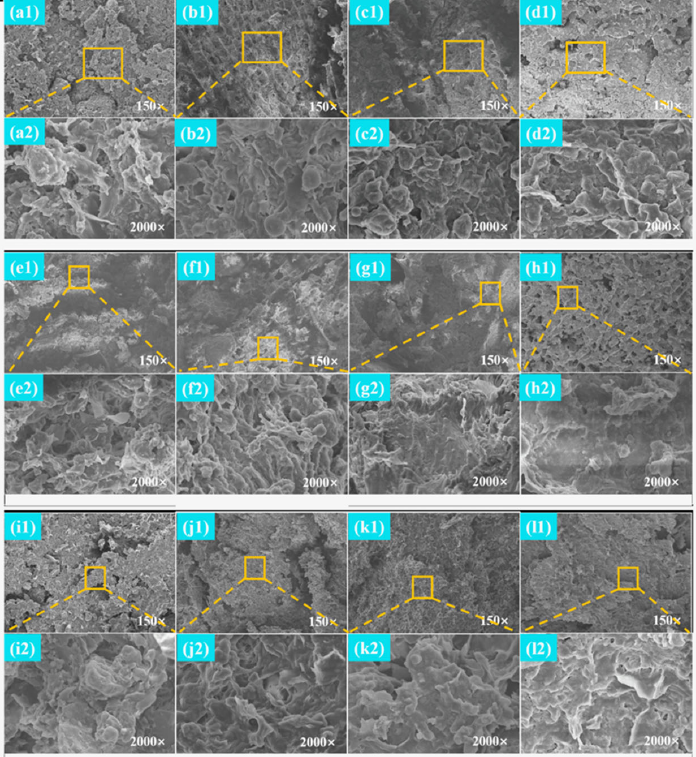
Figure 10. SEM images of ( a1 , a2 ) A1 ‐ pure HPMP, ( b1 , b2 ) B1 ‐ SDS/HPMP, ( c1 , c2 ) C1 ‐ SDS/nSiO 2 /HPMP, ( d1 , d2 ) D1 ‐ HPMP adhesives; SEM images of ( e1 , e2 ) B1 ‐ pure SBMP, ( f1 , f2 ) B2 ‐ SDS/SBMP, ( g1 , g2 ) C2 ‐ SDS/nSiO 2 /SBMP, ( h1 , h2 ) and D2 ‐ SBMP adhesives; SEM images of ( i1 , i2 ) A3 ‐ pure CSMP, ( j1 , j2 ) B3 ‐ SDS/CSMP, ( k1 , k2 ) C3 ‐ SDS/nSiO 2 /CSMP, ( l1 , l2 ) and D3 ‐ CSMP adhesives.